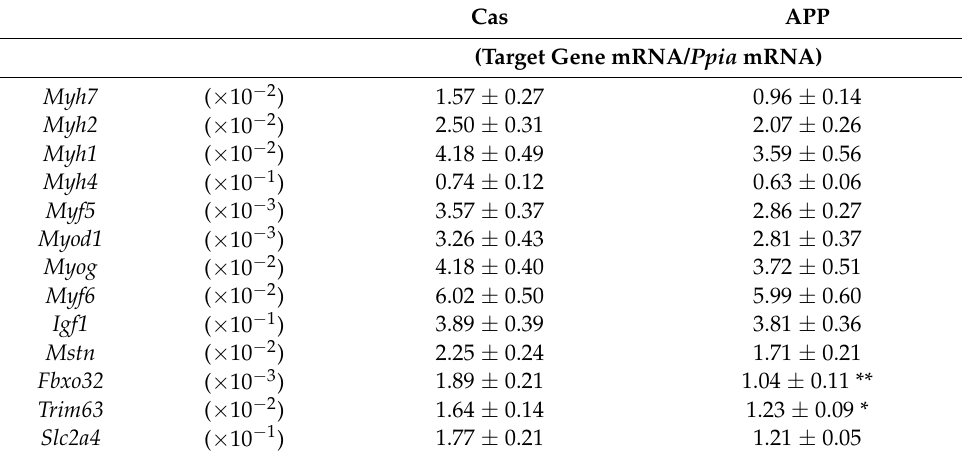
The gene expressions of myosin heavy chains and regulators of muscle mass and metabolism of normal fat-casein diet group (Cas, n = 8) and normal fat-APP diet group (APP, n = 8) after 2 days of feeding are shown. Data are expressed as the mean ± standard error (SEM). Asterisks indicate significant differences compared to the Cas group by unpaired Student’s t -test (*, p < 0.05; **, p < Table 4. The effect of APP for 2 days on gene expressions of myosin heavy chains and regulators of muscle mass and metabolism in the gastrocnemius muscles in rats fed a normal-fat diet.